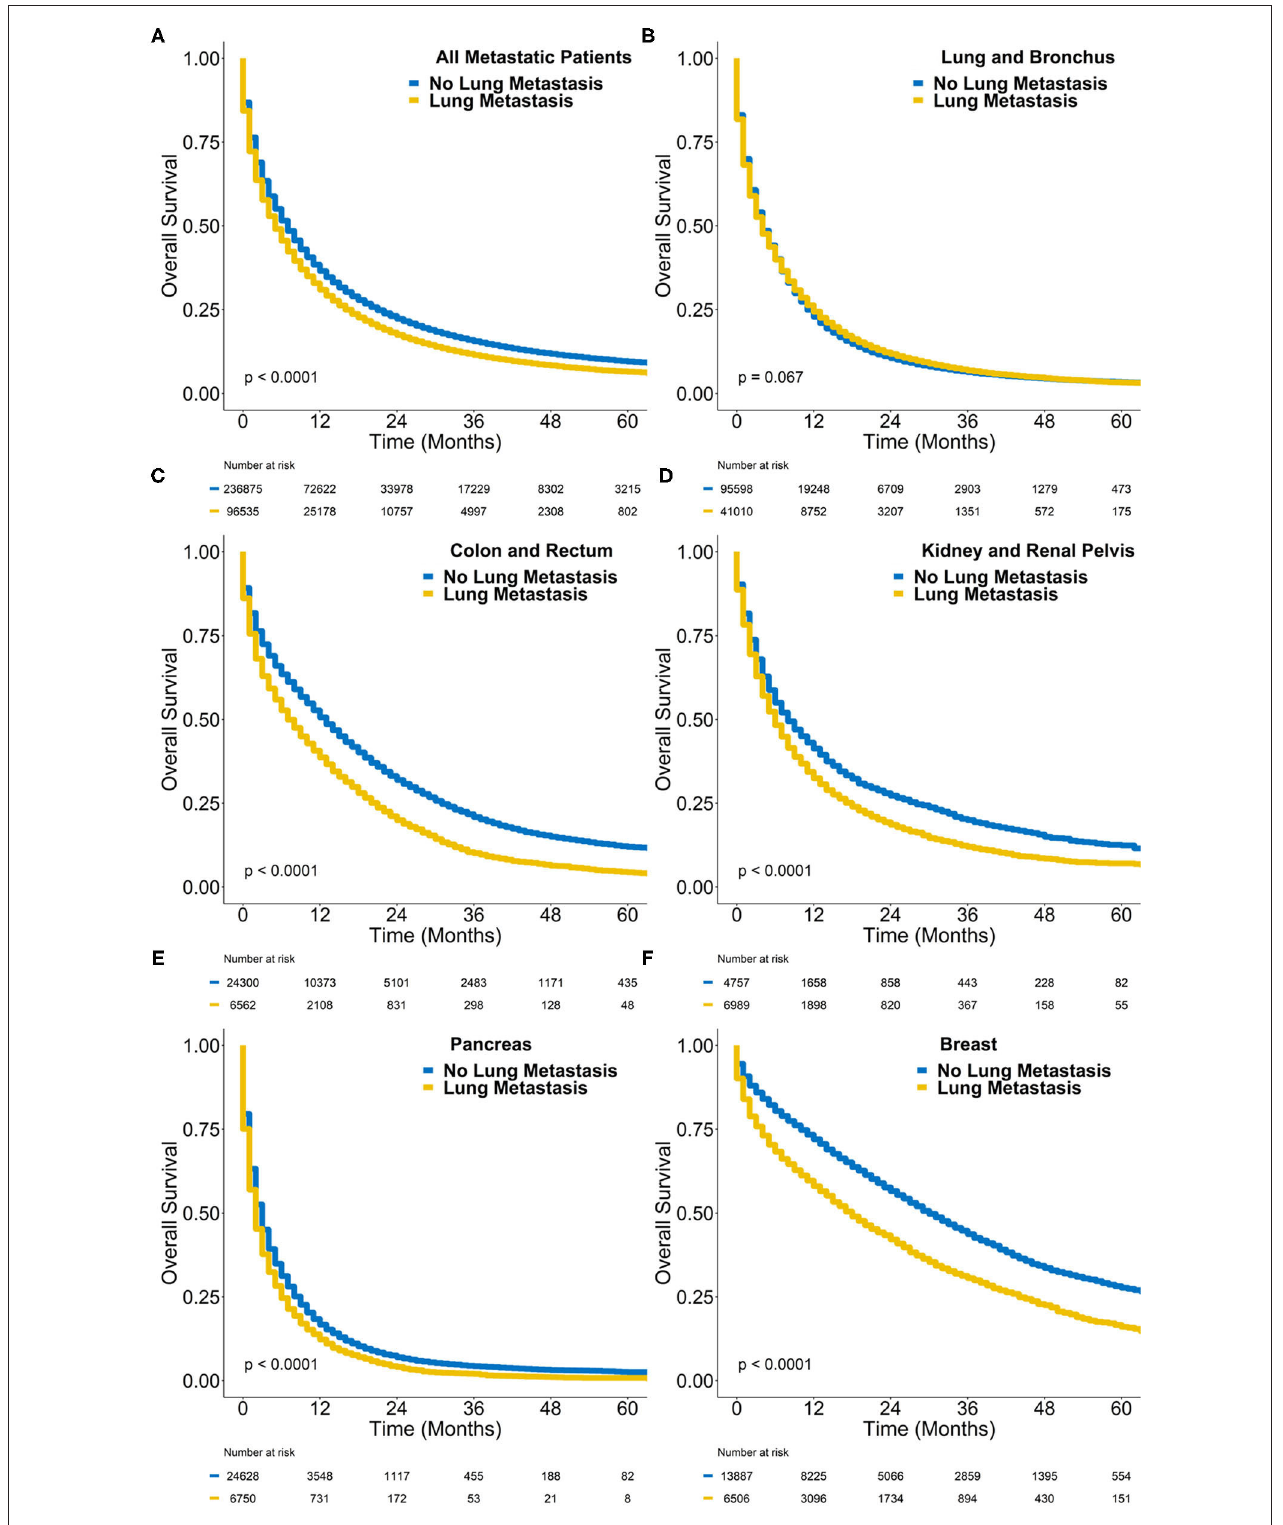
FIGURE 3 | Kaplan-Meier survival plot of overall survival probability (y-axis) vs. time in months (x-axis) comparing de novo metastatic cases with synchronous lung metastasis (yellow) to those without (blue) in (A) all cases, (B) lung cancer cases, (C) colorectal cancer cases, (D) kidney cancer cases, (E) pancreatic cancer cases, and (F) breast cancer cases. The P -value represents the results of a log-rank test.